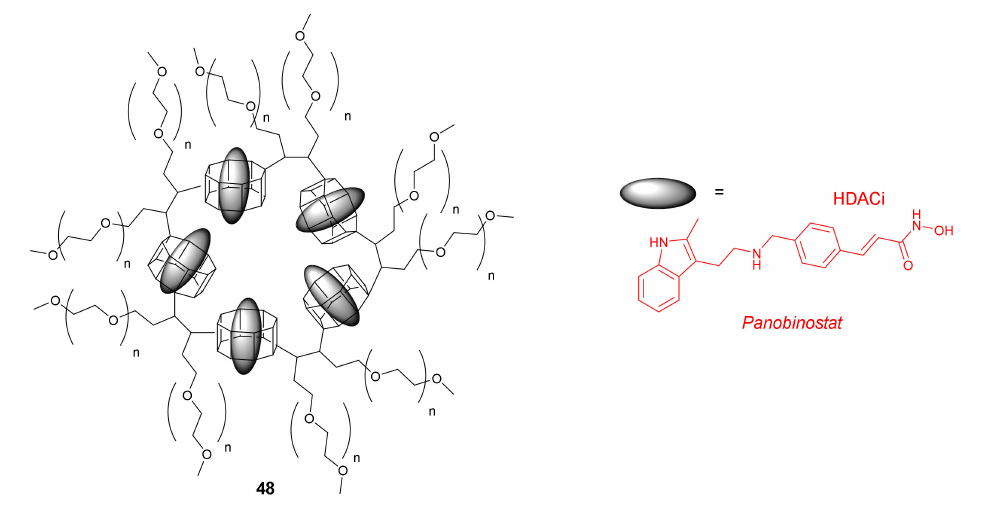
(Figure 23). An in vitro experiment of 48 with a murine glioblastoma GL261 cell line demonstrated an IC 50 value of 0.56 µ M, while the IC 50 value for free Panobinostat was 0.17 µ M. An in vivo study with mice injected with GL261 cells indicated that the treatment of tumors with PEG-CDN loaded with 30 µ g of Panobinostat resulted in a significant re- duction in tumor growth compared to PEG-CDN and saline controls. On the other hand, the median survival for Panobinostat -loaded PEG-CDN was 22 days, which was compa- rable to 20 days for PEG-CDN and saline controls, and therefore, the treatments did not significantly prolong survival of the animals.